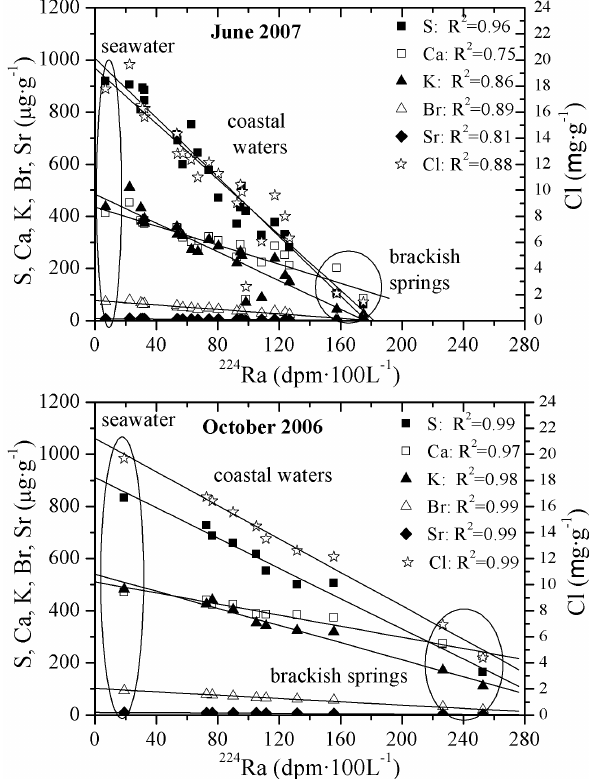
Fig. 7. Major element composition versus 224 Ra activities for Oc- tober 2006 and June